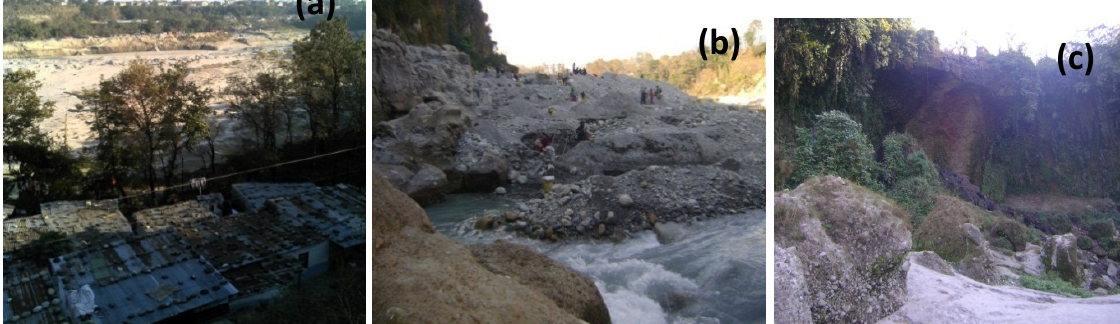
Figure 10. ( a ) Ramghat, 2014; ( b ) Nadipur, 2014; ( c ) Nadipur, 2014.